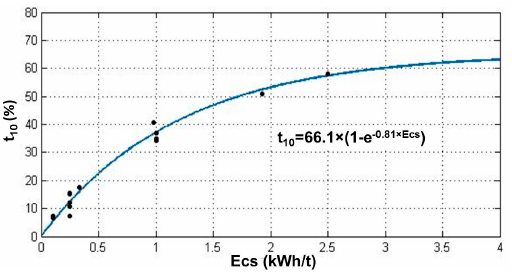
Figure 1. Fitted t 10 – E cs curve of the magnetite ore.